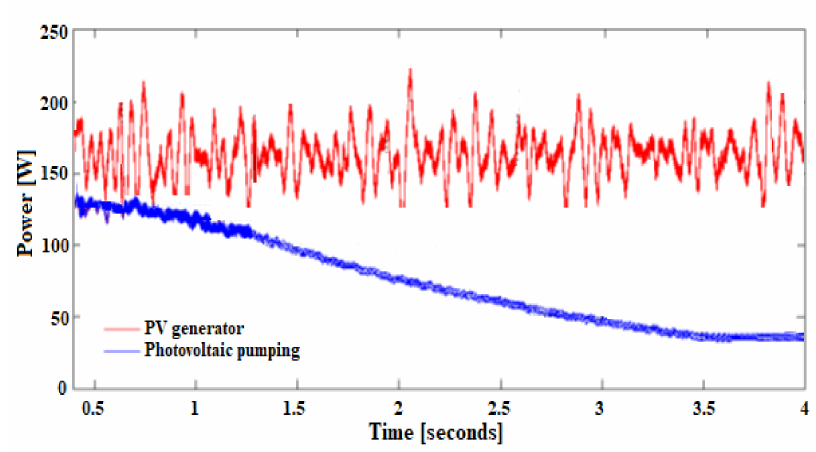
Figure 21. The performances of the PV pumping system in the case without MPPT.